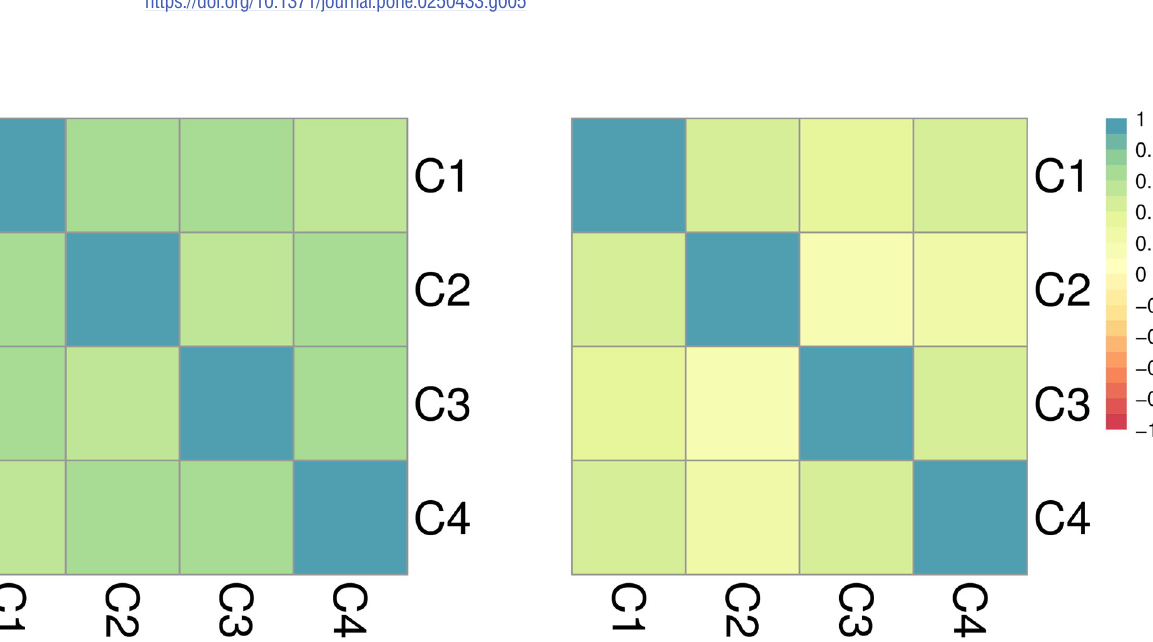
Fig 5. Weekly time series of disorder events { n } visualized by cluster, in India. Weeks are marked from week j = 1 (December j 29 th 2019 to January 4 th 2020) to week j = 50 (December 6 th to December 12 th 2020).